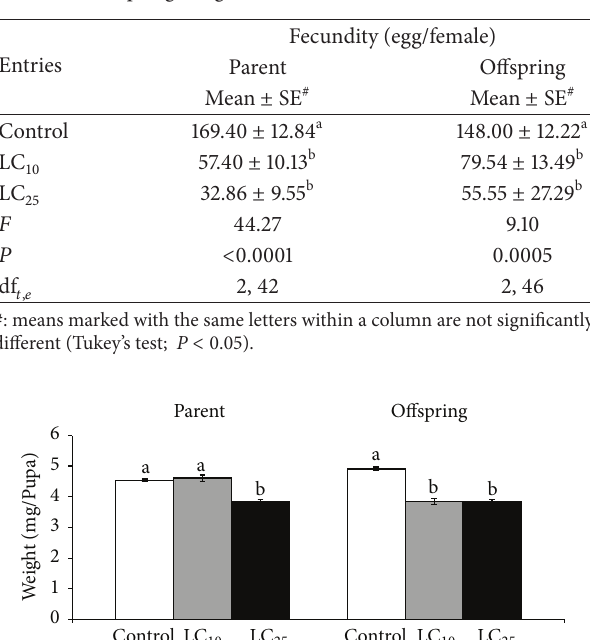
parent and offspring generations (Figure 1) (ANOVA; parent, F (2, 72) = 10.65, 𝑃 < 0.0001 ; offspring, F (2, 72) = 10.67, 𝑃 < 0.0001